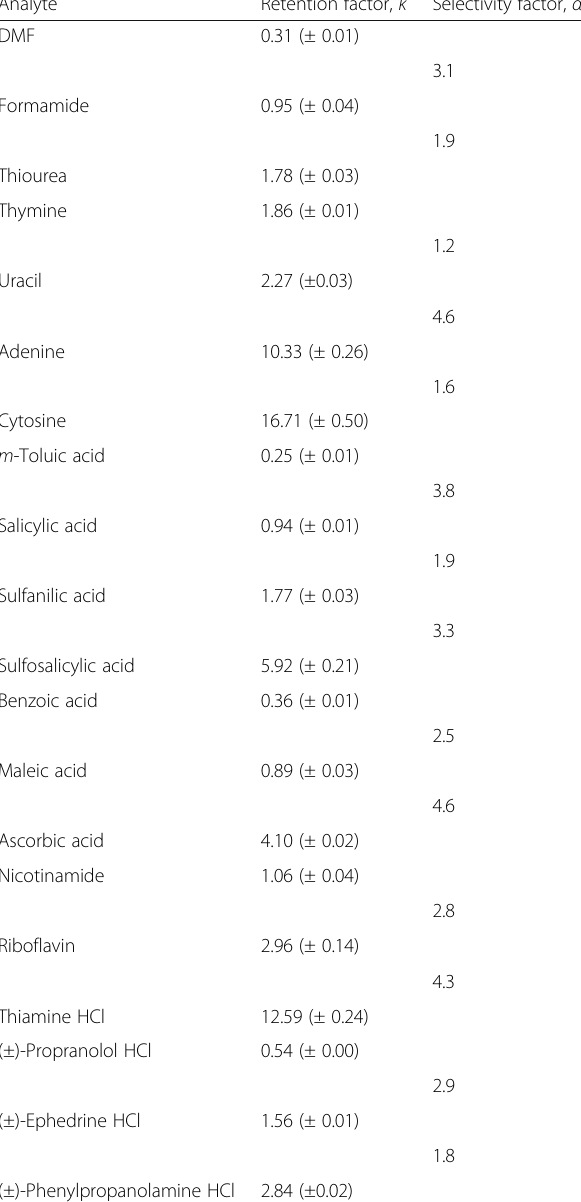
Table 1 k and α values obtained on 0.6 mg CN-FSNPs/cm- poly(GMM-co-EDMA) monolithic